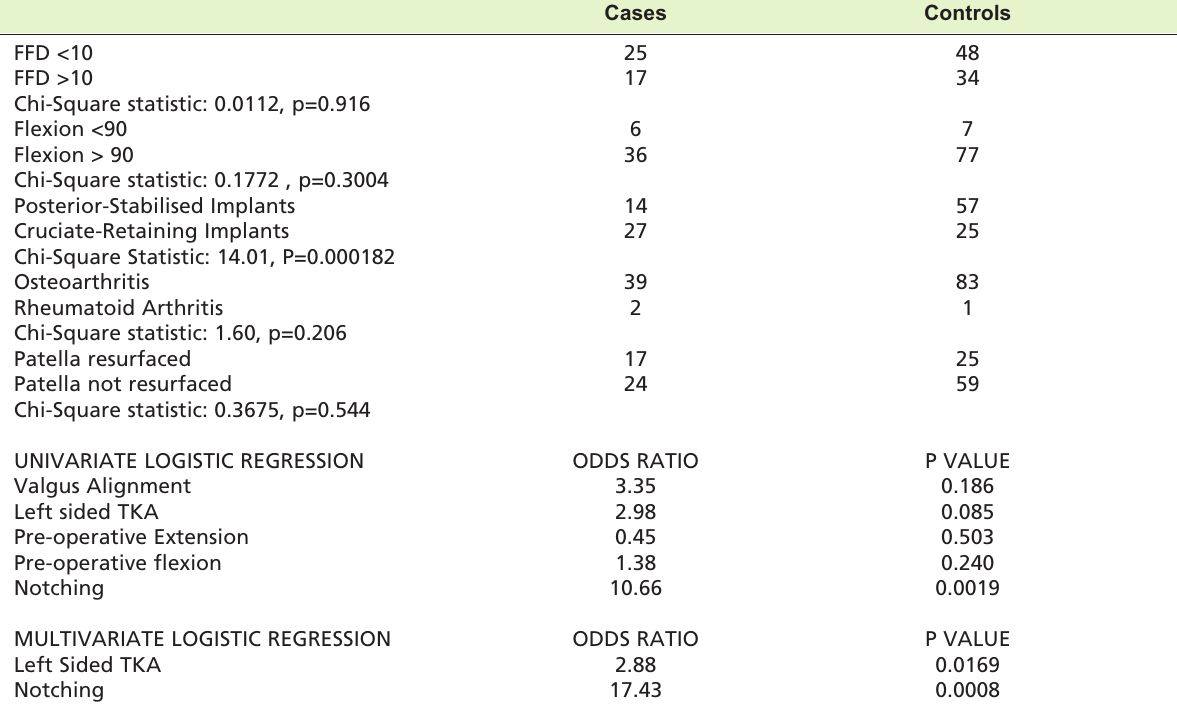
Summary of statistical analysis Table II: